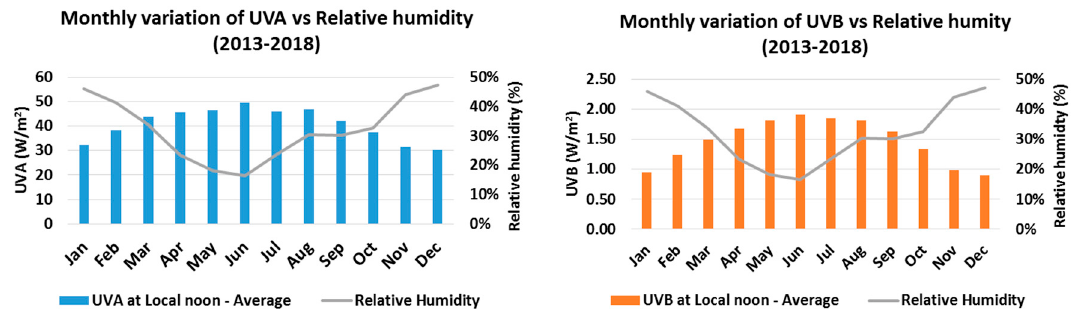
Figure 5. Diurnal (intraday) variation of UVA ( left ) and UVB ( right ) radiation (averaged from 2013 to 2018) on four dates (1 January, 1 April, 1 July, and 1 October) to show the seasonal variation at Doha, Qatar. The maxima for both radiations occur at local noon time in Qatar.